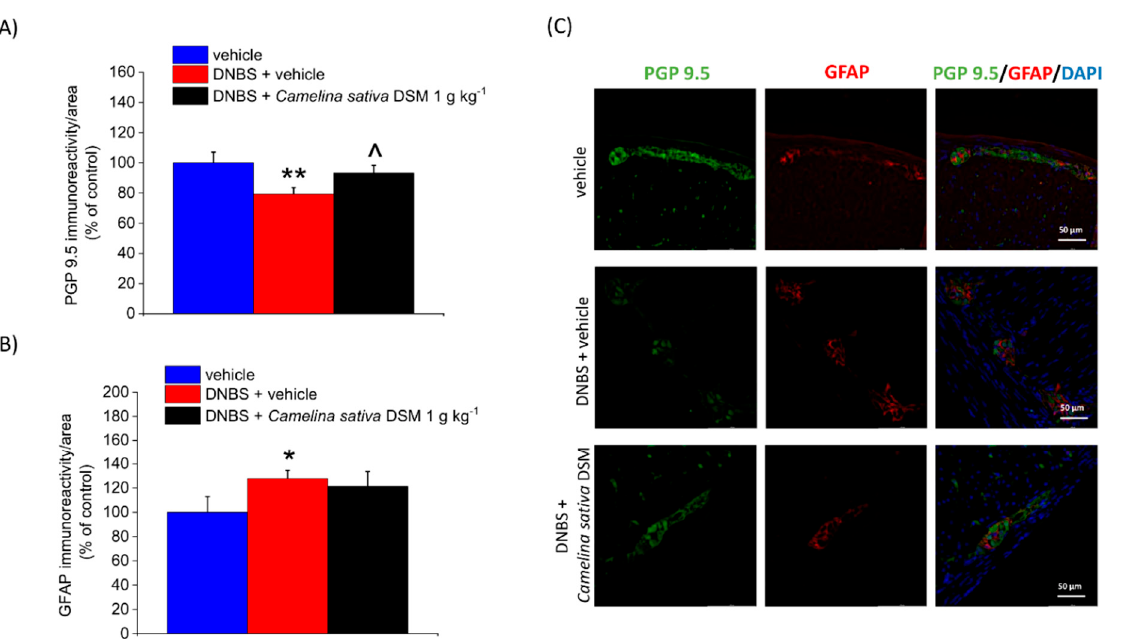
Figure 8. The neuroprotective effects of Camelina sativa DSM on the colonic myenteric plexus of DNBS- treated rats. Camelina sativa DSM (1 g kg − 1 ) was administered once daily in the DNBS-treated animals, starting from the day of DNBS injection for 14 consecutive days, and then tissues were collected. The immunolabeling quantification of PGP 9.5 ( A ) and GFAP ( B ) with relative immunofluorescence images showing the expression of PGP 9.5 (green), GFAP (red), and DAPI (blue) in the myenteric plexus of the colon ( C ). The quantitative analysis of PGP9.5- and GFAP-related immunofluorescence intensity (arbitrary unit) was performed by collecting independent fields (4–6 for each animal) from the myenteric plexi. Results were expressed as a percentage of the control group (vehicle-treated animals). Each value represents the mean ± SEM of six animals per group. * p < 0.05 vs. vehicle. ** p < 0.01 vs. vehicle. ˆ p < 0.05 vs. DNBS + vehicle. Original magnification: 40×.